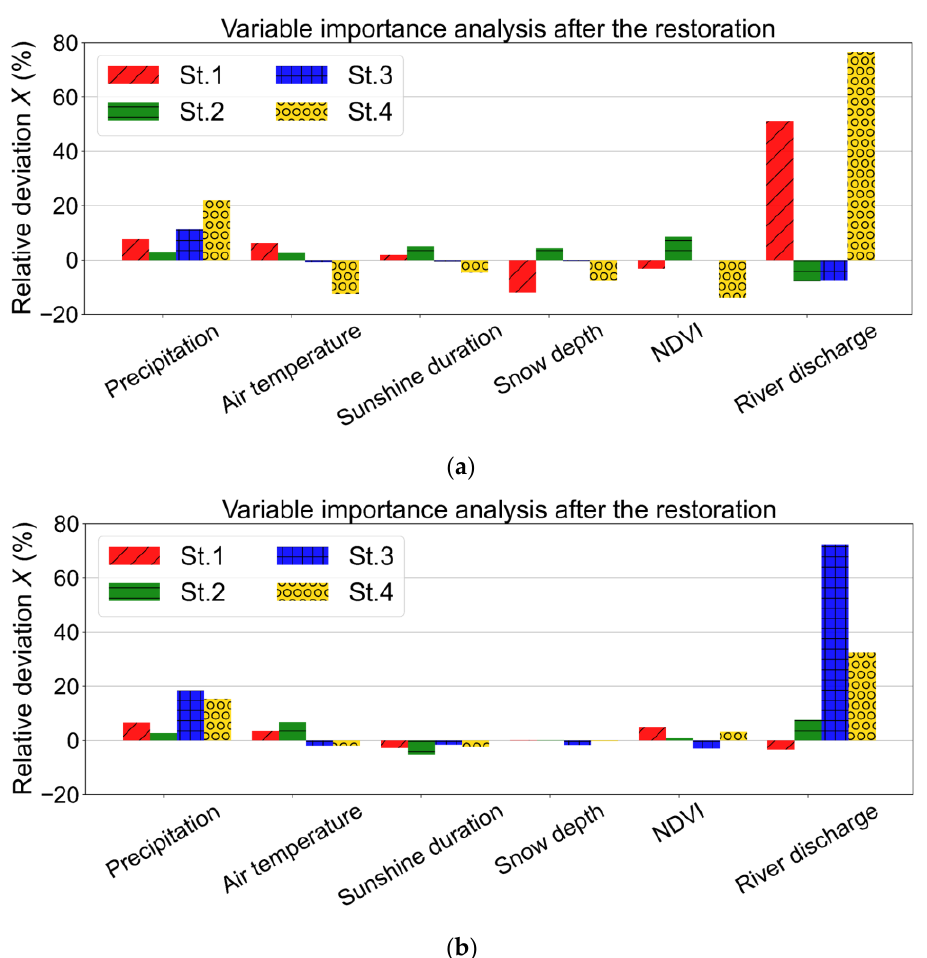
Figure 11. Importance analysis of the explanatory variables in the LSTM models by AWM: ( a ) Before the meandering stream channel restoration. ( b ) After the meandering stream channel restoration.